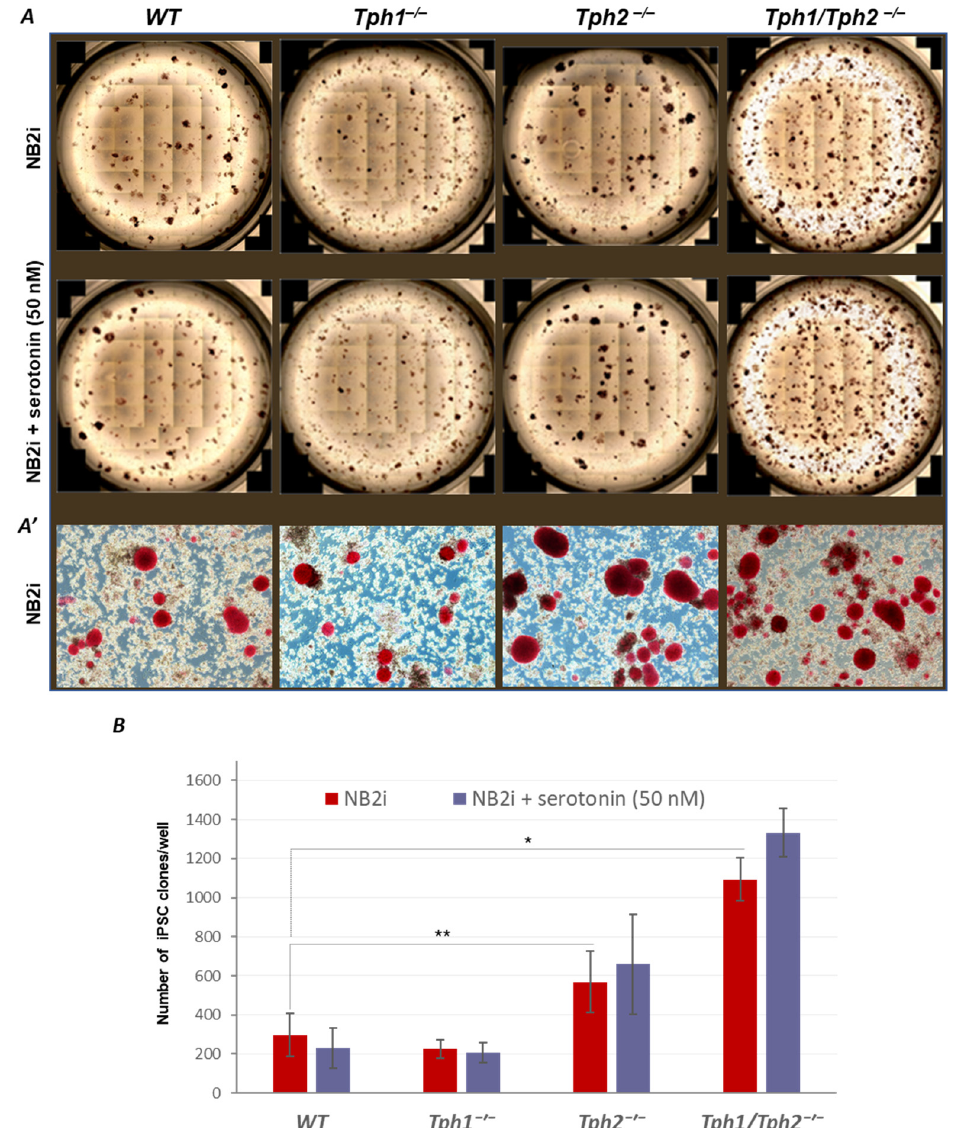
Figure 1. Loss of serotonin (5-HT) biosynthesis leads to a robust increase of the efficiency of OKSM-mediated MEF reprogramming to iPSCs regardless of serotonin presence in the medium. MEFs of the indicated genotypes were reprogrammed using an inducible rtTA/OKSM polycistronic vector under serum-free N2B27-2i (NB2i) conditions. ( A ) Color photographs of 3-cm wells containing alkaline phosphatase (AP)-positive iPSC clones (red staining) generated without (upper panel) or in the presence of serotonin at 50 nM (lower panel). ( A’ ) View of the AP-positive clones from corresponding wells at a higher (10-fold) magnification. ( B ) Counts of AP-positive clones generated during the reprogramming experiments presented in A. The reprogramming of the Tph1/Tph2 − / − and Tph2 − / − MEFs was about four and two times as efficient as that of wild-type (WT) MEFs (red bars), respectively, and was not affected by 50 nM serotonin presence in the medium (blue bars). Y -axis represent counts of the AP-positive iPSC clones ± standard deviations (SD); n = 4, * p < 0.0005, ** p < 0.05; Student’s t